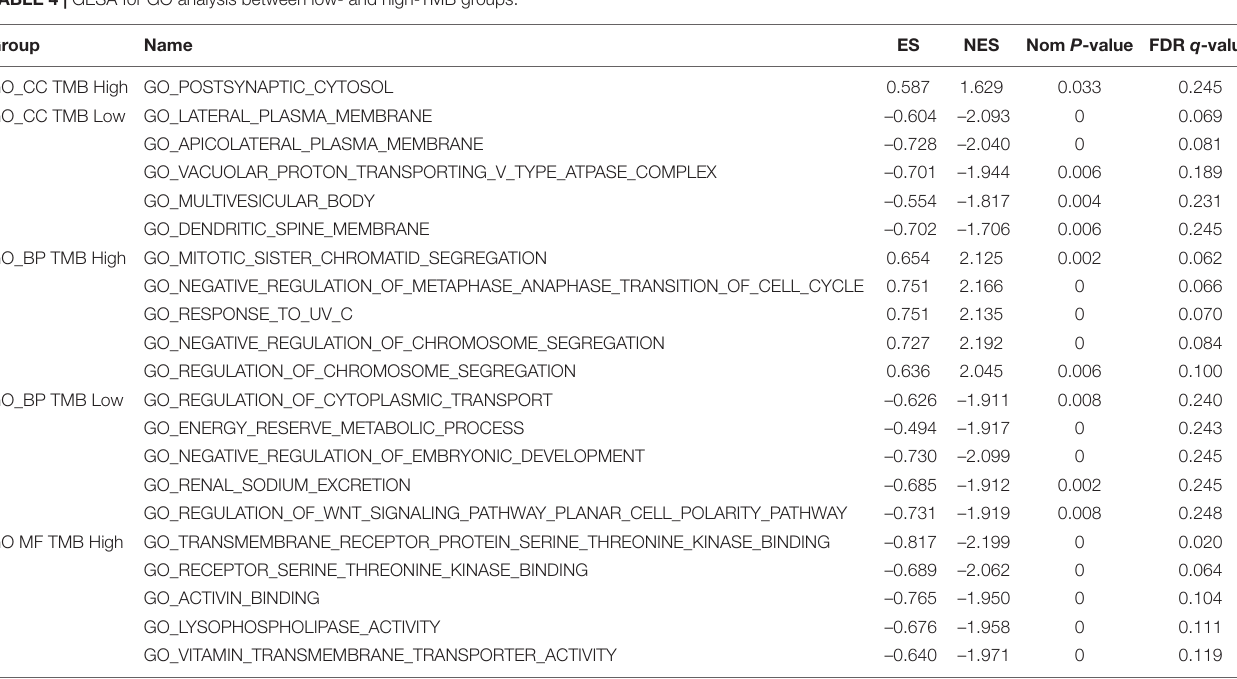
TABLE 4 | GESA for GO analysis between low- and high-TMB groups.